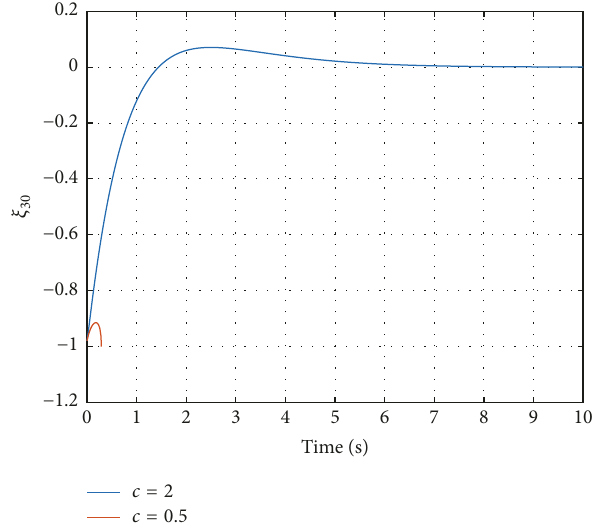
Figure 4: Stability of (29) for different values of 𝑐